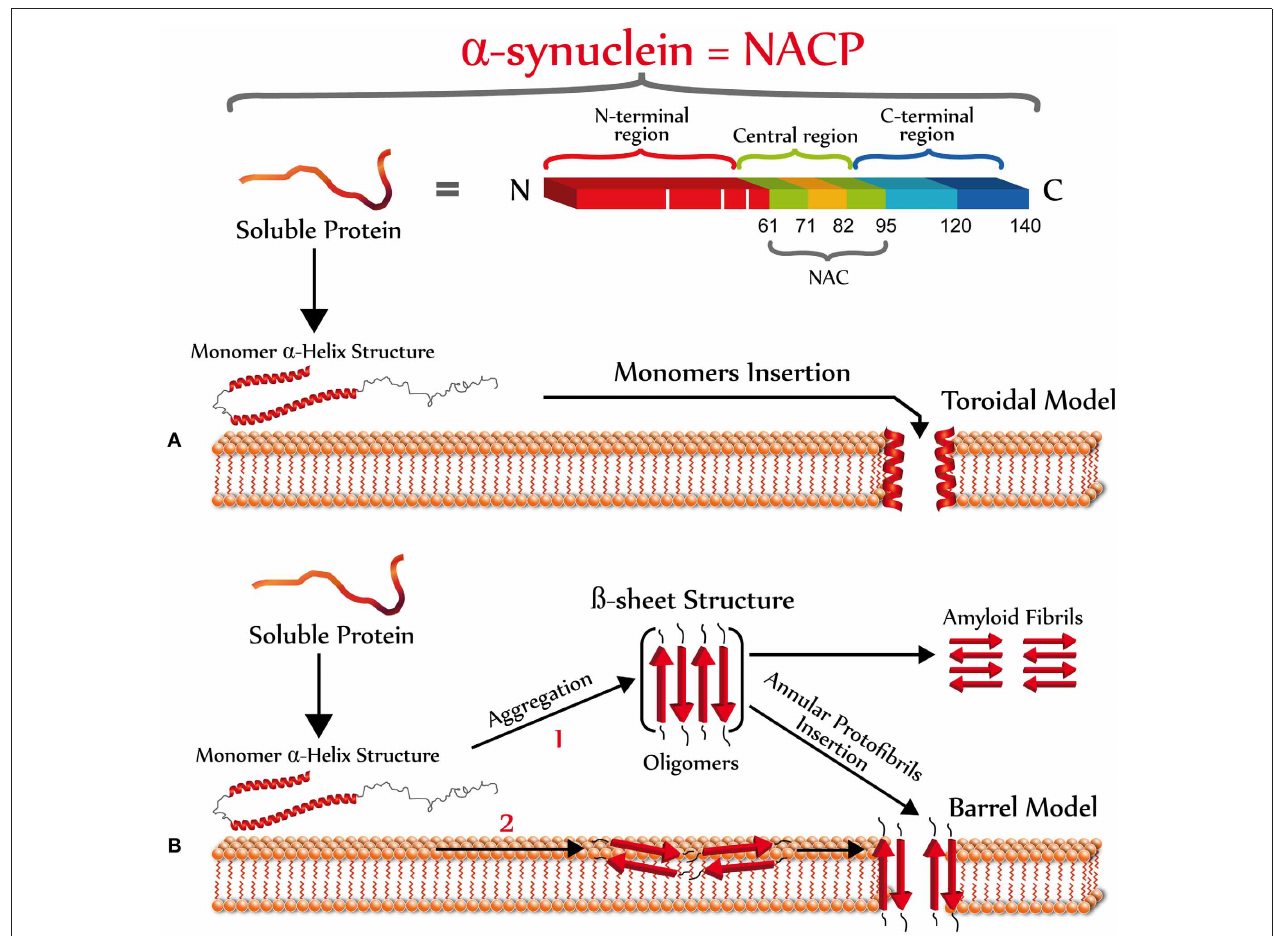
FIGURE 3 | Primary and secondary structure of α -synuclein. Top scheme shows the three main domains of α -synuclein. The N-terminal (red) is an amphipathic domain that contains the three point mutations (white bars) linked to the autosomal dominant form of PD (Bisaglia et al., 2009). The central region (green-pale brown) is a highly hydrophobic domain that was originally identified in patients with AD or LBD, which is the precursor of the non amyloidogenic component of the extracellular senile plaque (NAC), which promotes the protein aggregation (Ueda et al., 1993). The C-terminal domain (blue) has an acidic character, which possesses anti-amyloidogenic properties (Hoyer et al., 2004). According to the operational model of membrane